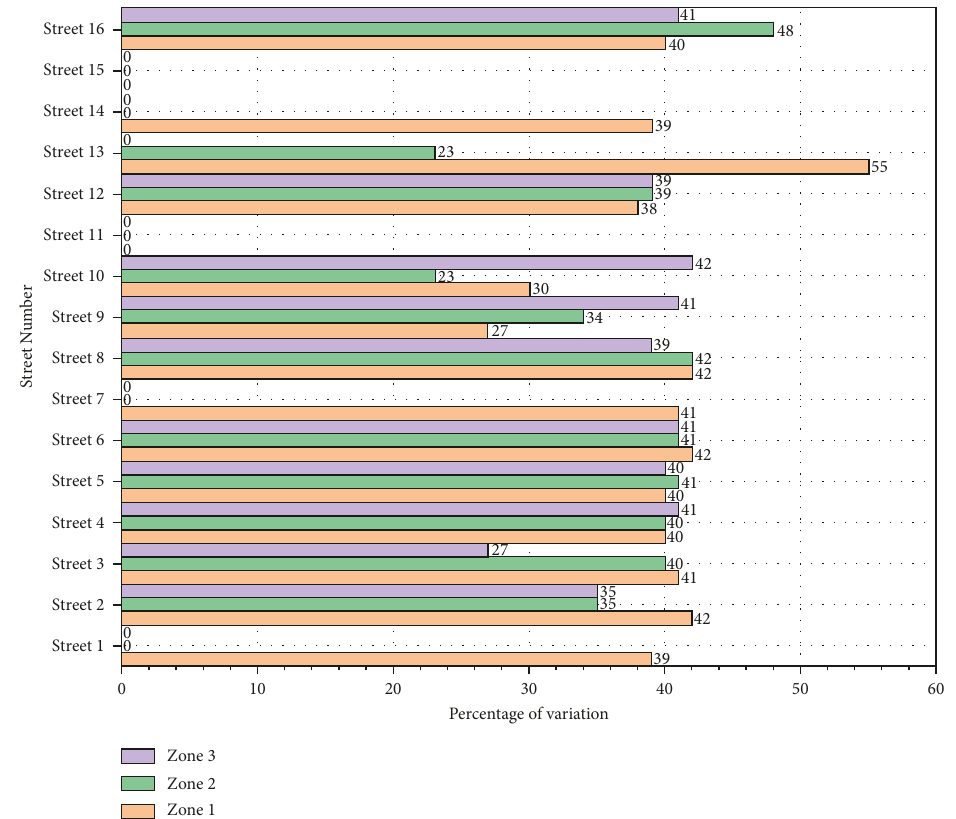
Figure 14: Percentage of variation between effective width ESVI values for collapse type 2 for investigated roads at different seismic